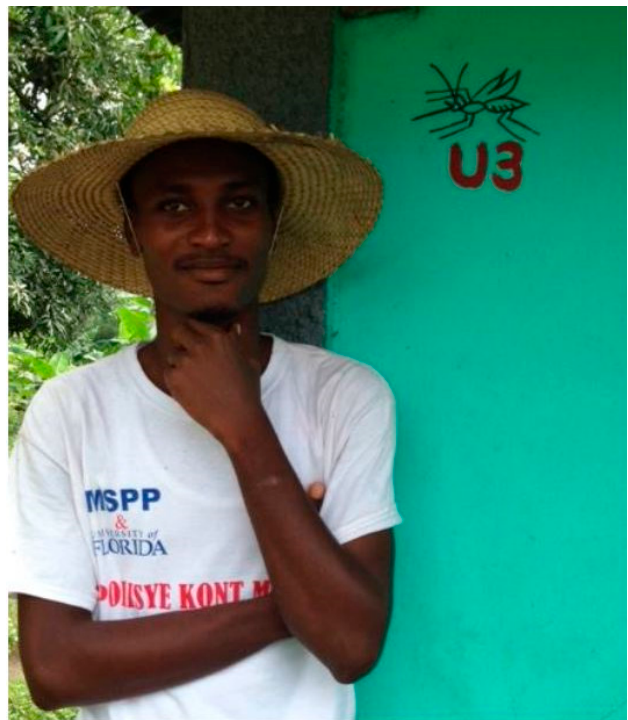
Figure 1. A PKM with an example of our mosquito code in the background.